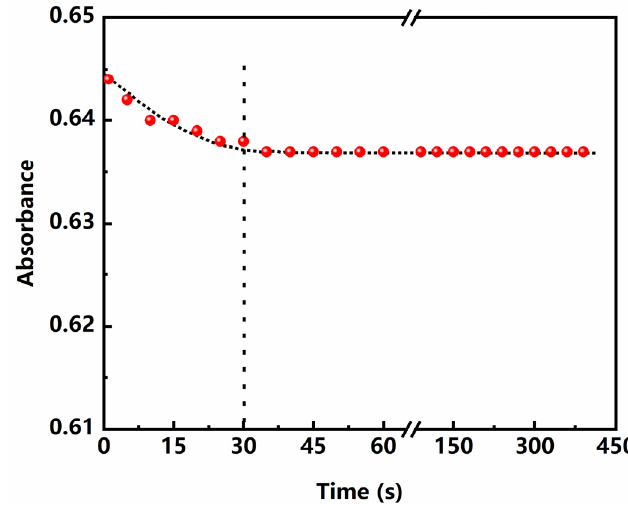
Figure 5. Effect of reaction time on the absorbance.